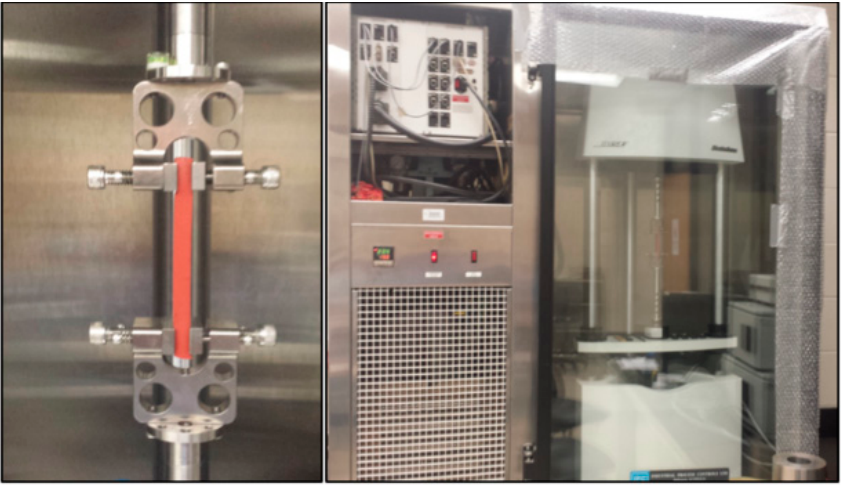
Figure 7. Testing rubber specimen in the dynamic mechanical analyzer (DMA) device inside a temperature-control chamber.